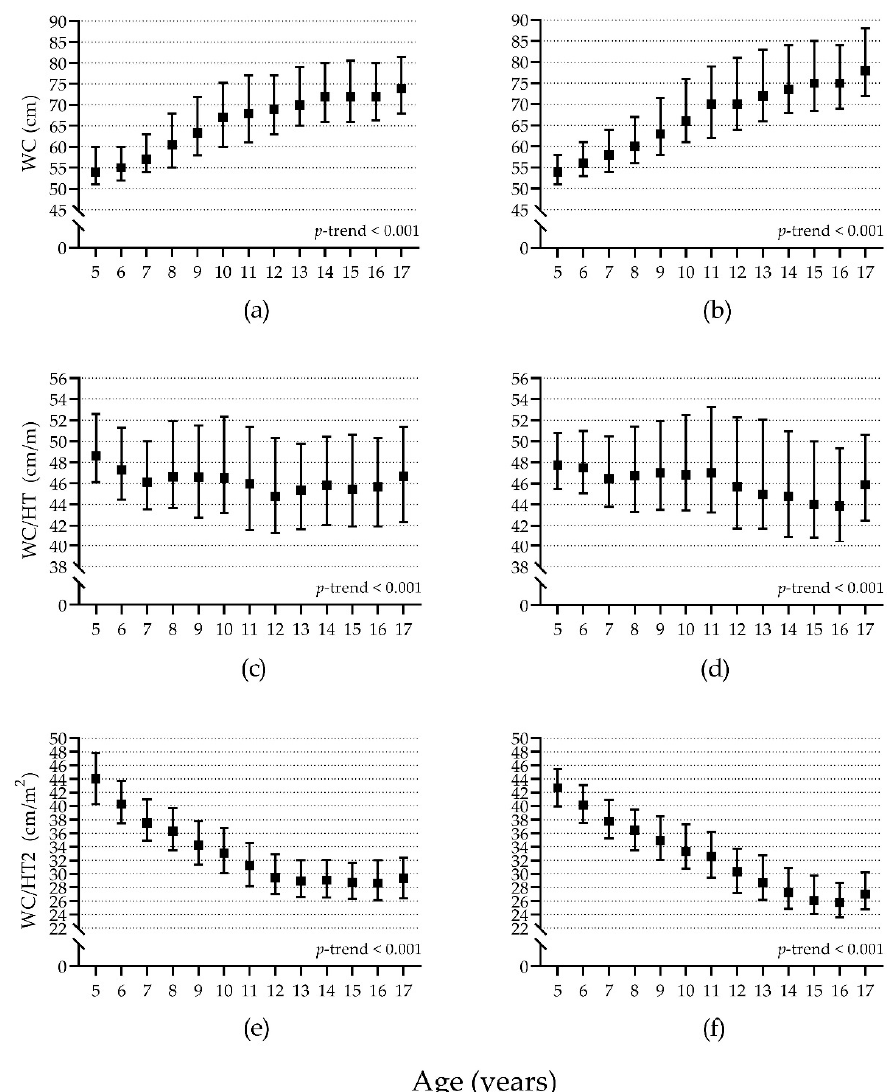
Figure 3. Waist circumference (WC) ( a , b ), waist circumference corrected for height (WC/HT) ( c , d ), and waist circumference corrected for height squared (WC/HT2) ( e , f ) comparison by age in girls ( a , c , e ) ( n = 6998) and boys ( b , d , f ) ( n = 5981). Solid squares represent the median values; whiskers represent the 25th and 75th percentiles. p -trend calculated with the Kruskal-Wallis H test.